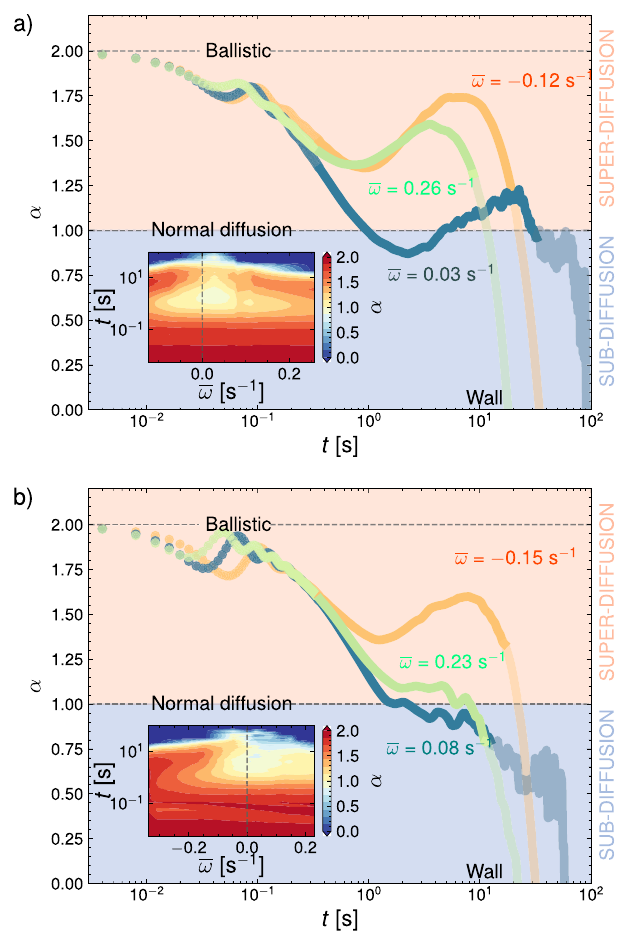
Fig. 4 Evolution of the diffusive exponent α . We show the results for three experiments with ω < 0 ; ω ¼ 0 ; ω > 0 respectively (each represented in a different color of curve), at two different packing fractions: a ϕ = 0.45 and b ϕ = 0.25. Here, t represents lag time. The diffusive exponent has been calculated by performing a rolling fi t of the mean squared displacement to a t α slope. The ballistic regime and normal diffusion regimes are signaled with horizontal lines at α = 2 and α = 1, respectively. Translucent lines indicate that the system boundary has been reached. Heat-maps in the insets represent α in the ω (cid:2) t plane (notice the dip at large t , for the case ω ’